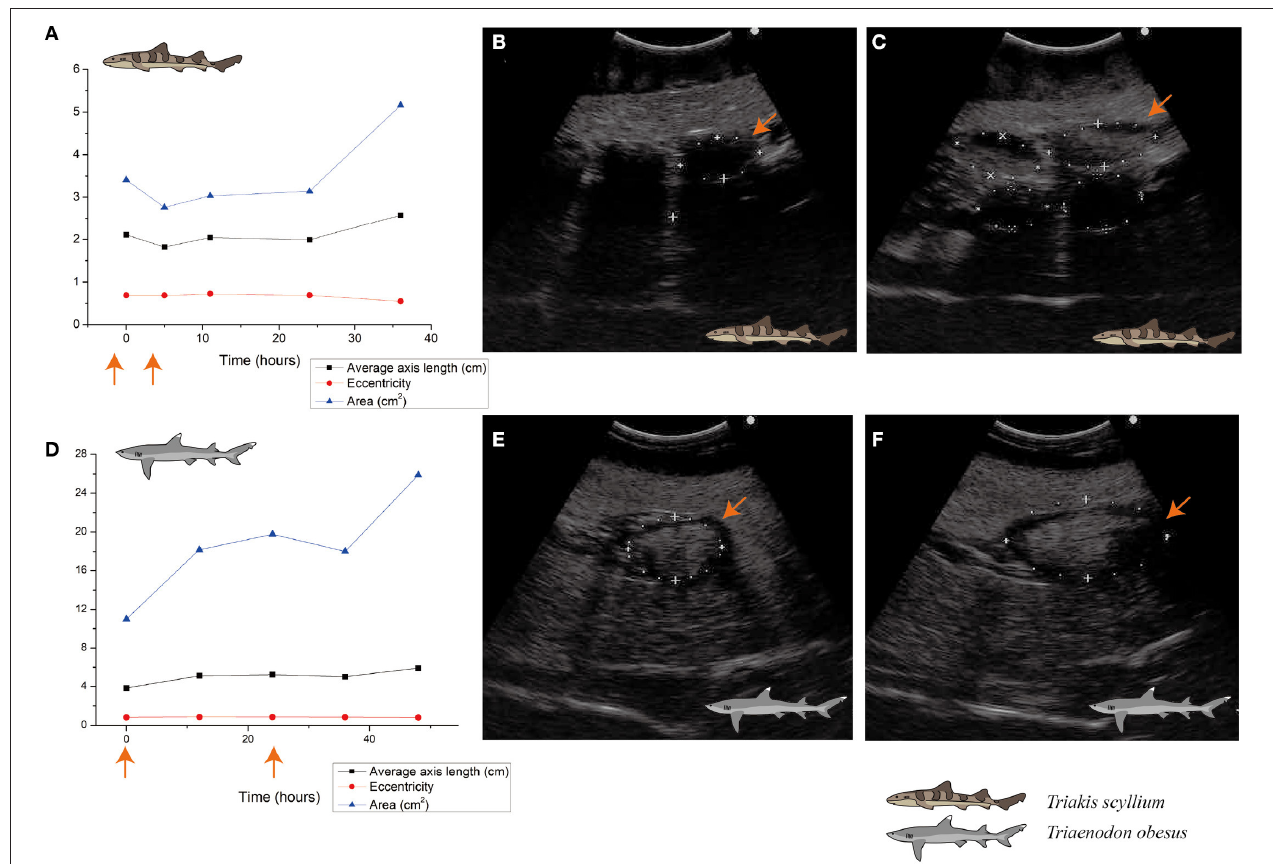
FIGURE 4 | Ovarian follicle size change after Ovaprim ® injection in Triakis scyllium and Triaenodon obesus. (A) Ovarian follicle size changes after Ovaprim ® injection in female T. scyllium . Axis length and area values were measured directly on ultrasonography. Eccentricity was calculated with the long and short axis values. The orange arrows indicate the time points of Ovaprim ® administration. (B) Ultrasonography of left ovary before Ovaprim ® injection in T. scyllium (F003). The orange arrows indicate the same follicle in (C) at different time point. Size of the follicle with the orange arrow was 3.7cm × 1.9cm (5.45 cm 2 ). (C) Ultrasonography of left ovary after Ovaprim ® injection in T. scyllium (F003). Follicles showed distinct size increase. The orange arrows indicate the same follicle in (B) at different time point. Size of the follicle with the orange arrow was 4.9cm × 2.0cm (7.60 cm 2 ). (D) Ovarian follicle size changes after Ovaprim ® injection in female T. obesus . Axis length and area values were measured directly on ultrasonography. Eccentricity was calculated with the long and short axis values. The orange arrows indicate the time points of Ovaprim ® injection. (E) Ultrasonography of left ovary before Ovaprim ® injection in WF002 ( T. obesus ). The orange arrows indicate the same follicle in (F) at different time point. Size change of the follicles can be recognized by ultrasonography. Size of the follicle with the orange arrow was 4.4cm × 3.0cm (10.27 cm 2 ). (F) Ultrasonography of left ovary after Ovaprim ® injection in WF002 ( T. obesus ). The orange arrows indicate the same follicle in (E) at different time point. Size of the follicle with the orange arrow was 7.4cm × 3.7cm (21.77 cm 2